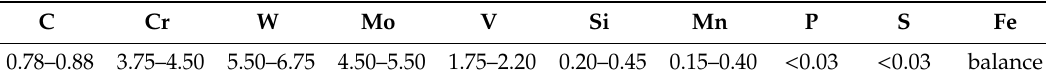
Table 1. Chemical composition of M2 high steel